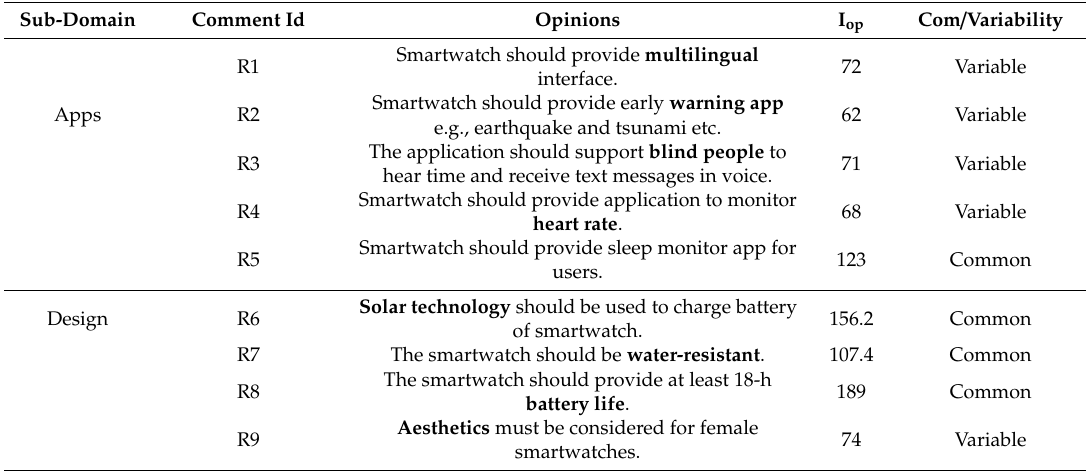
Table 4. Example of elicited Value-Oriented